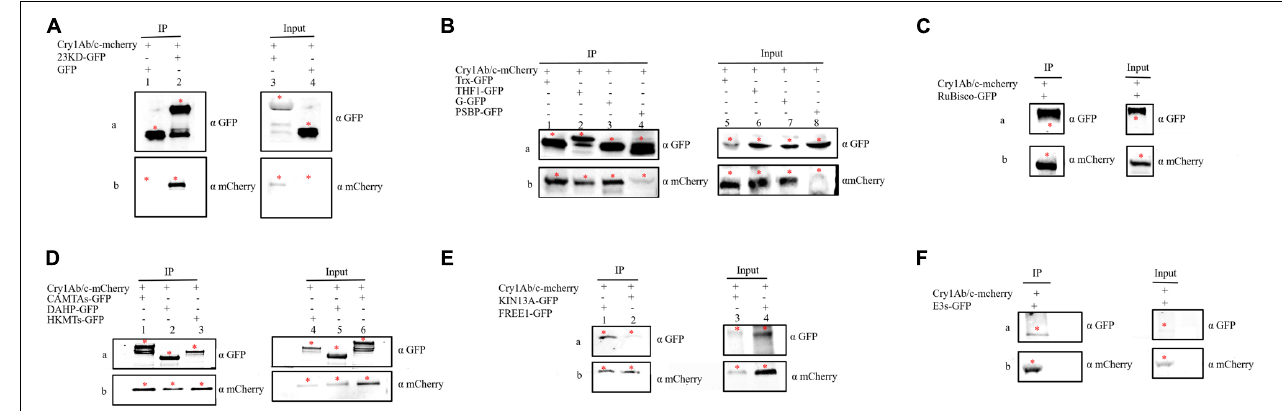
FIGURE 5 | The co-immunoprecipitation was used to verify interactions between the full-length Cry1Ab/c protein and 12 endogenous proteins. Protein extracts (Input) were immunoprecipitated with GFP-trap beads (IP) and resolved by SDS-PAGE. The immunoblots shown were developed with anti-GFP antibody to detect the target endogenous protein involved in photosynthesis and stress resistance (a) and with anti-mCherry antibody to detect Cry1Ab/c (b, 94 kDa). (A) GFP + Cry1Ab/c-cherry (27 kDa, lanes 1 and 4), 23KD-GFP + Cry1Ab/c-cherry (47 kDa, lanes 2 and 3); (B) Trx-GFP + Cry1Ab/c-cherry (48 kDa, lanes 1 and 5), THF1-GFP + Cry1Ab/c-cherry(59 kDa, lanes 2 and 6), G-GFP + Cry1Ab/c-cherry (45 kDa, lane 3 and 7), PSBP-GFP + Cry1Ab/c-cherry (50 kDa, lanes 4 and 8); (C) Rubisco-GFP + Cry1Ab/c-cherry (80 kDa); (D) CAMTAs-GFP + Cry1Ab/c-mCherry (117 kDa, lanes 1 and 6), DAHP-GFP + Cry1Ab/c-mCherry (86 kDa, lanes 2 and 5), HKMTs-GFP + Cry1Ab/c-cherry (102 kDa, lanes 3 and 4); (E) FREE1-GFP + Cry1Ab/c-cherry (116 kDa, lanes 1 and 4), KIN13A-GFP + Cry1Ab/c-cherry (117 kDa, lanes 10 and 11); and (F) E3s-GFP + Cry1Ab/c-cherry (83 kDa, lanes 14 and 17). The red asterisk indicates the target band.